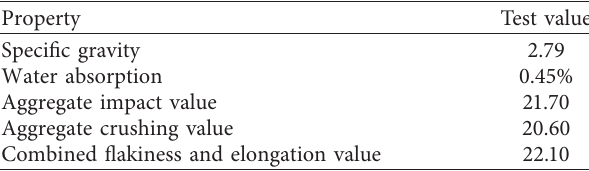
Table 3: Test values for coarse